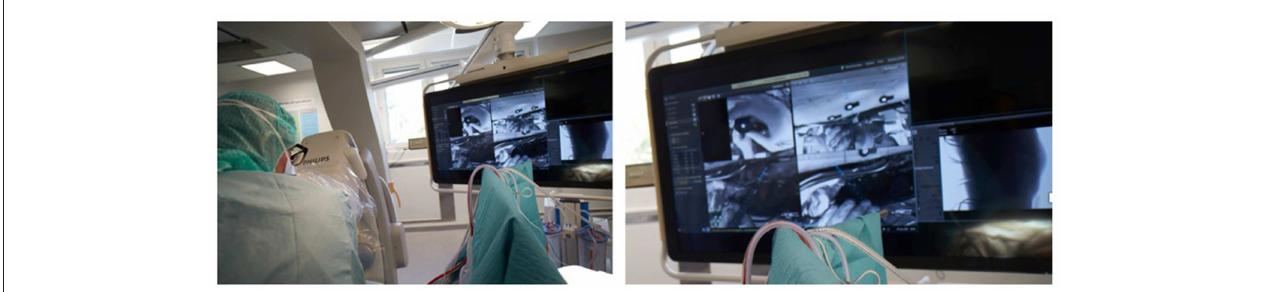
FIGURE 1 | (Left) Picture showing a surgeon from Karolinska hospital in Stockholm using a hybrid operating room with an augmented reality system integrated with the robotic C-arm. (Right) The surgeon is seeing at the screen the video streaming of his surgery with a blue line indicating the direction of his instruments that he is navigating into the pedicle (Photo courtesy of Dr. Rami